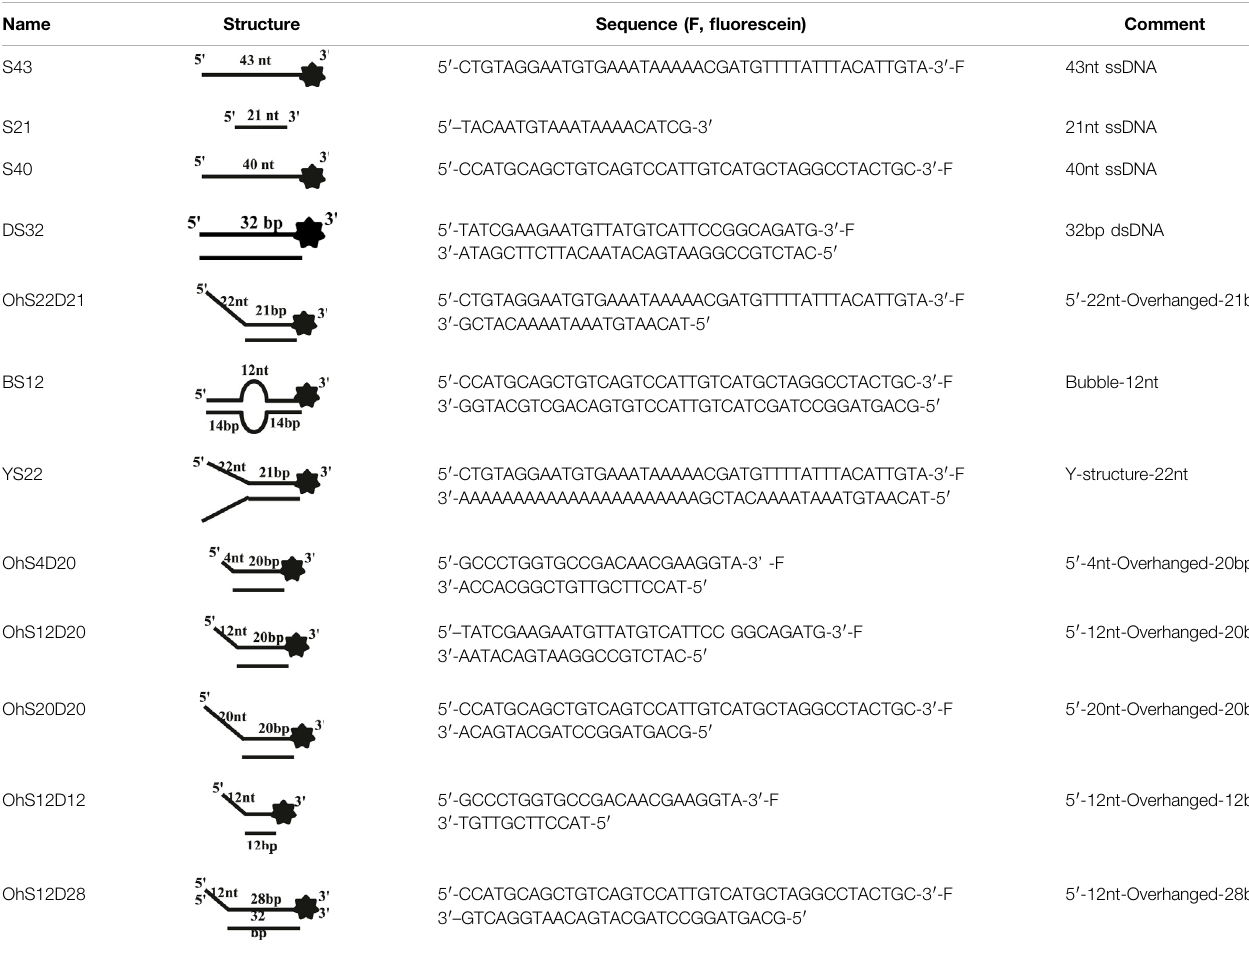
TABLE 1 | . Structures and sequences of the DNA substrates. Name